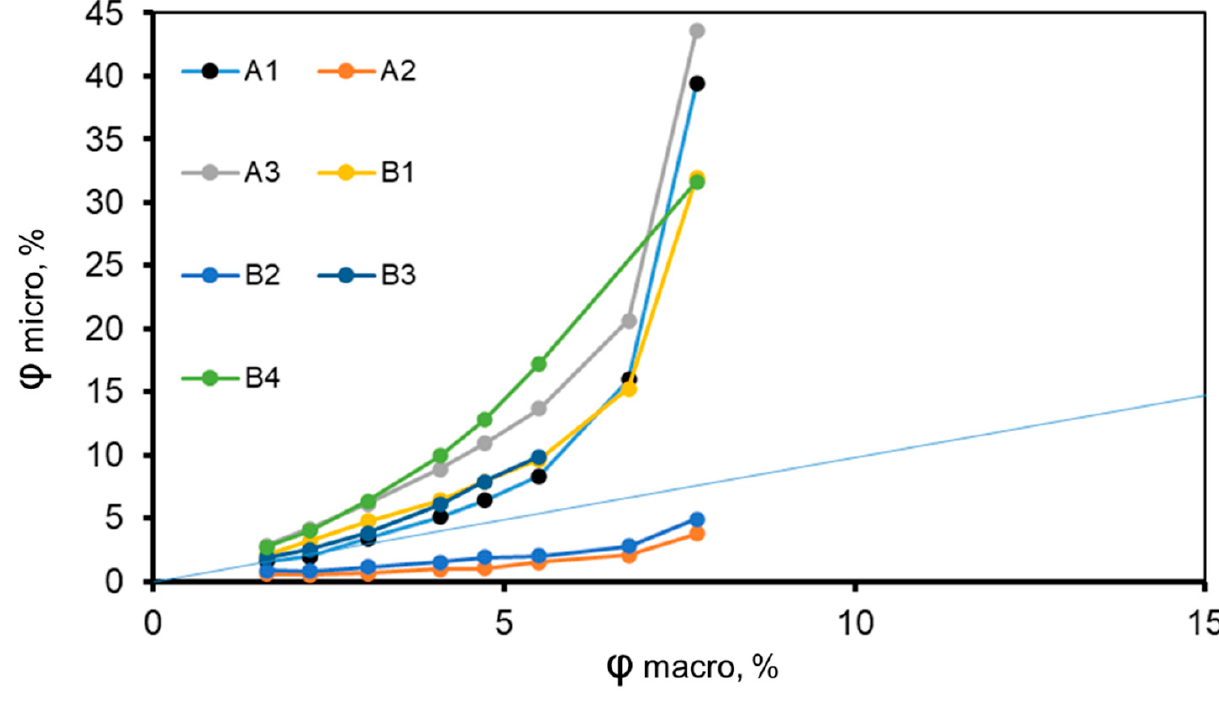
Figure A9. Comparison of meso deformation and micro deformation. The frame by frame evolution of local strain distribution around (left) and within (right) the MnS inclusion is presented in Figure A10 from 1.6% to 7.75% global true